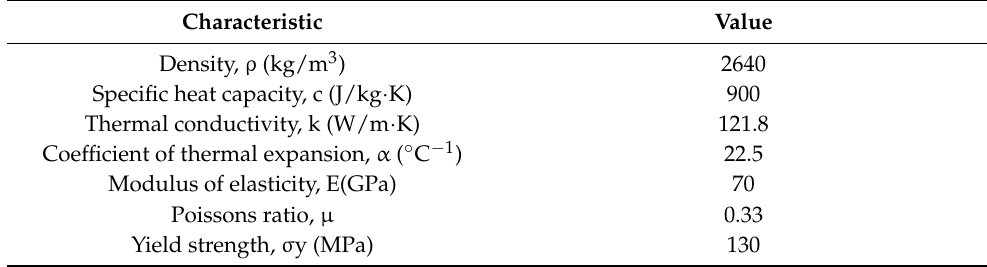
Table 2. Properties of the 5356 aluminum alloy at 25 °C.